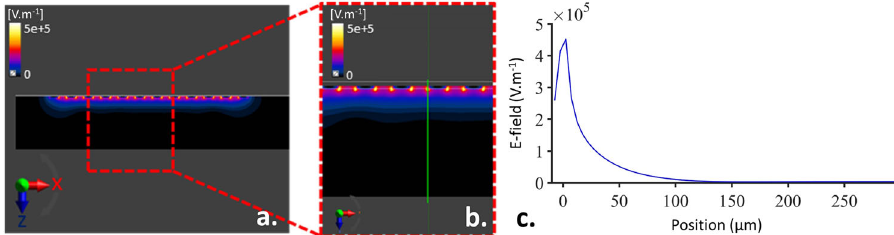
Fig. 3 Numerical simulations of the electric fi eld. a Spatial distribution of the electric fi eld as a function of distance from the electrodes. b Zoom on a region of interest with only subset of interdigitated electrodes. c View of the electric fi eld magnitude along the green line represented in